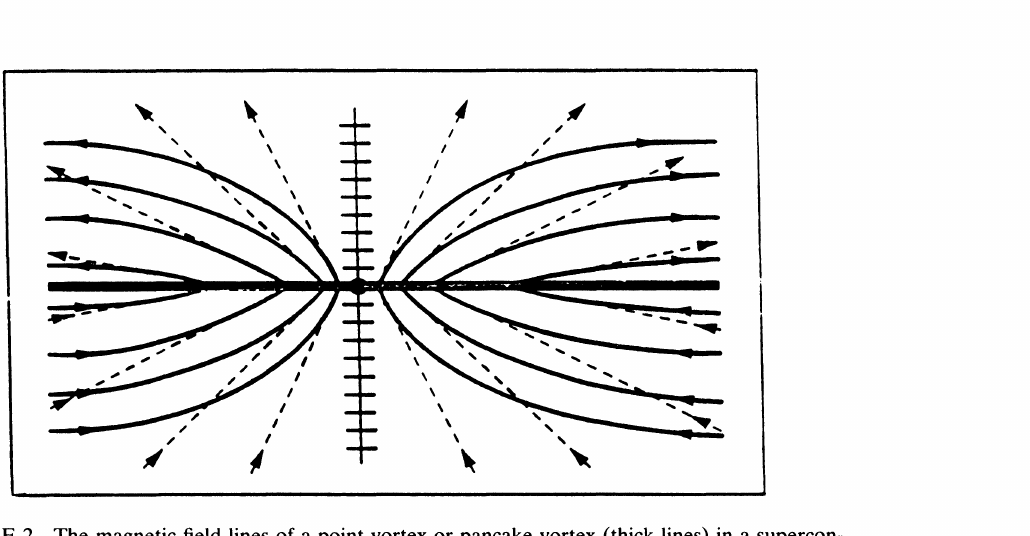
FIGURE 2 The magnetic field lines of a point vortex or pancake vortex (thick lines) in a supercon- ductor consisting of almost isolated superconducting layers indicated by the dashes near the z-axis (the crystalline c-axis). Compared to the field lines of a point vortex in a thin film (dashed lines), the field lines in a layered structure curve such that they become parallel to the layers at large distances from the vortex core. Their field is thus confined to a disk of thickness